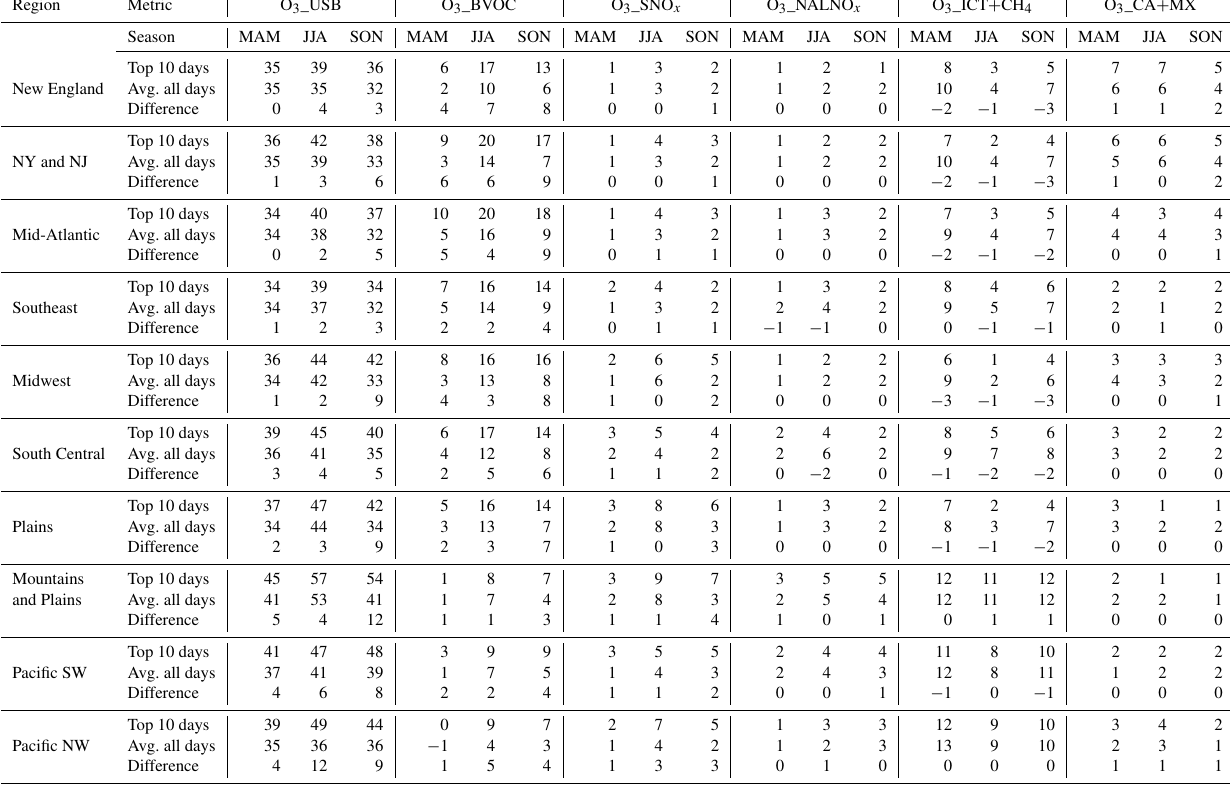
Table 3. Summary information for each region. Each column shows the concentration for each background O 3 source influence (1) on the O 3 _top10obs days in each season (average of 2004–2012), (2) across all days in each season (average of 2004–2012), and (3) the difference between these values, rounded to the nearest whole number.